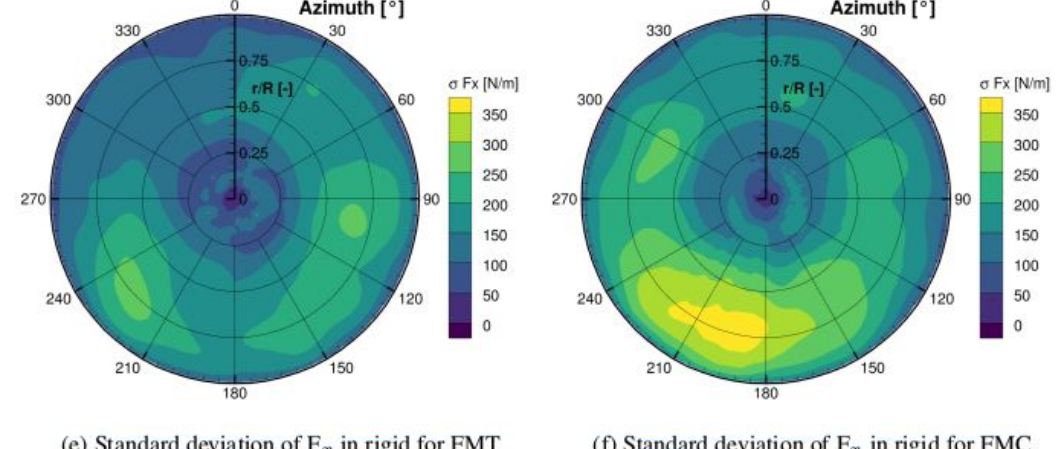
Figure 12. Phase average of the thrust force of one blade calculated over 26 revolutions. Loads are normalized according to the average in FMT and FMC, respectively. Difference is calculated as ( F x flexible ) − ( F x rigid ) . Standard deviation is calculated for the rigid case.